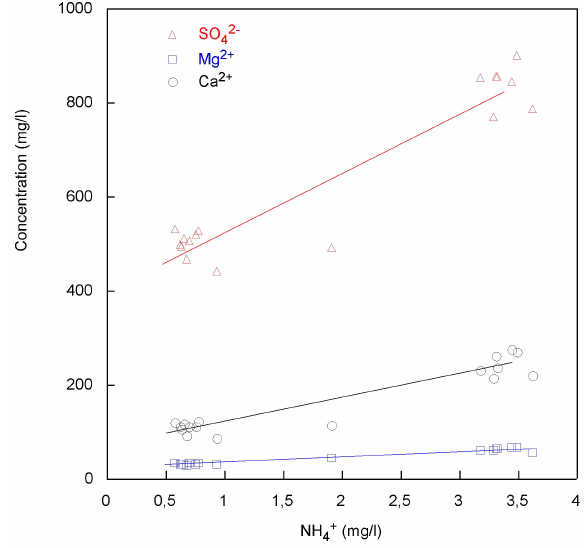
Figure 11. Correlation of Ca 2 + , Mg 2 + , and SO 2 − Popocatépetl